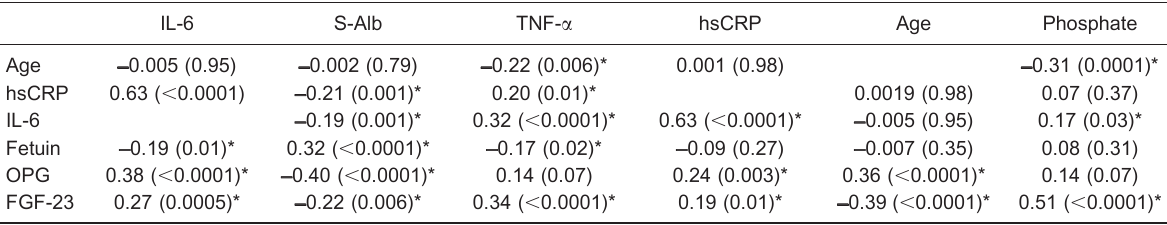
Table 3. Spearman rank correlation between plasma inflammatory and vascular calcification